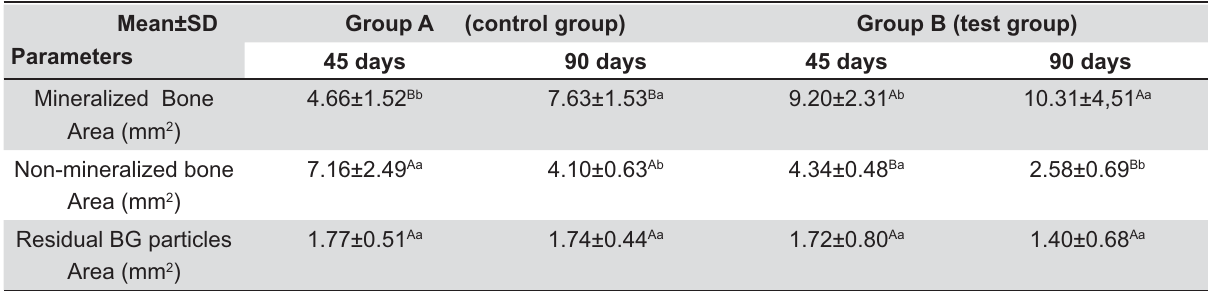
Table 2- Mean and Standard Deviation (SD) for the area parameters evaluated after all the treatments (bioactive glass+guided- tissue regeneration and bioactive glass+platelet-rich plasma+guided-tissue regeneration) in both periods